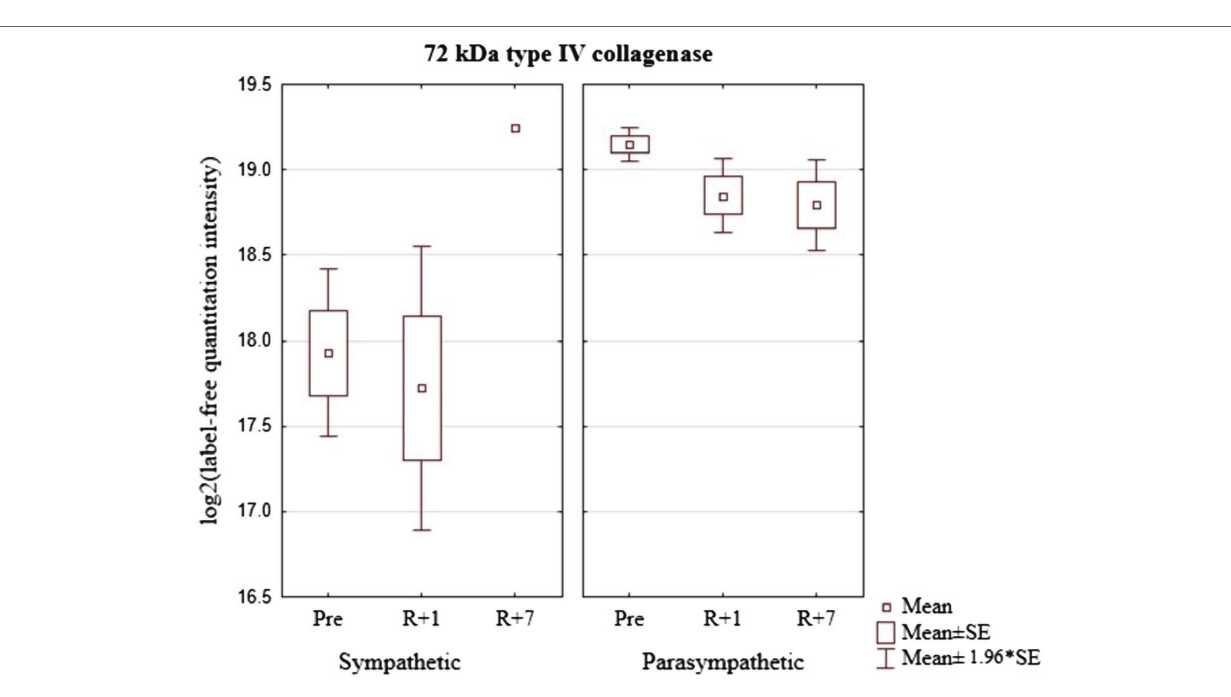
FIGURE 6 | Protein-72 kDa type IV collagenase (Gene MMP2) in cosmonaut groups pre-mission (Pre), on the 1st day (R + 1) and on the 7th day (R + 7) after